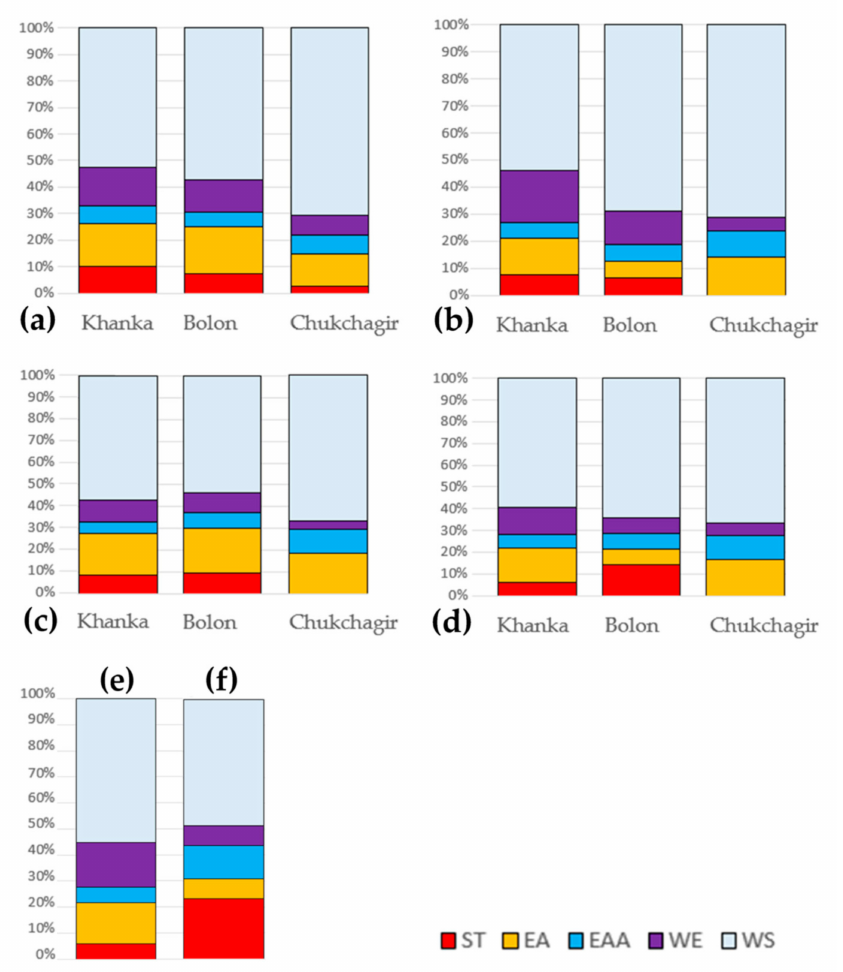
Figure 2. Portions of the taxa belonging to the different faunistic complexes of microcrustaceans ( a ) and only Cladocera ( b ) in the three studied lakes; the same for the taxa in the species associations (at p < 0.05) of microcrustaceans ( c ) and Cladocera ( d ), the rate of different faunistic complexes among the taxa in the associations ( e ), and the rate of the taxa not involved in any species associations ( f ) in the water bodies studied